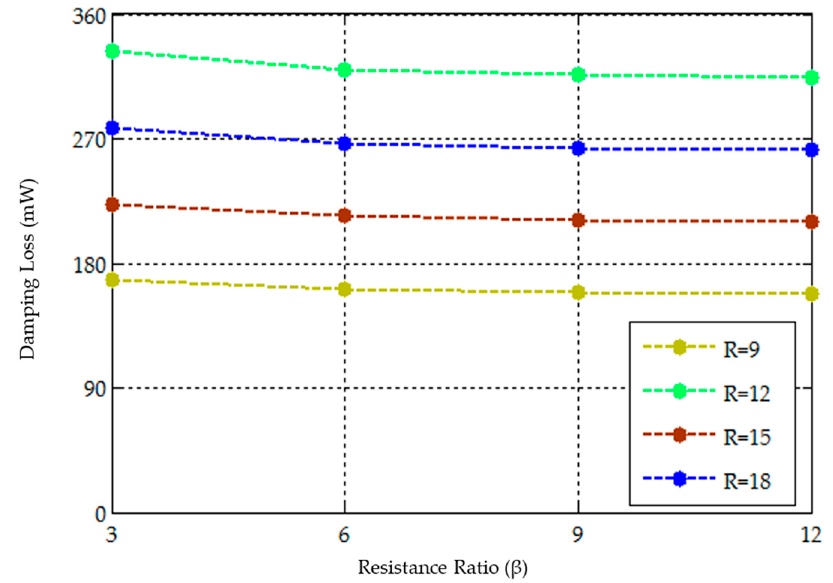
Figure 7. Damping loss variation with resistance ratio.